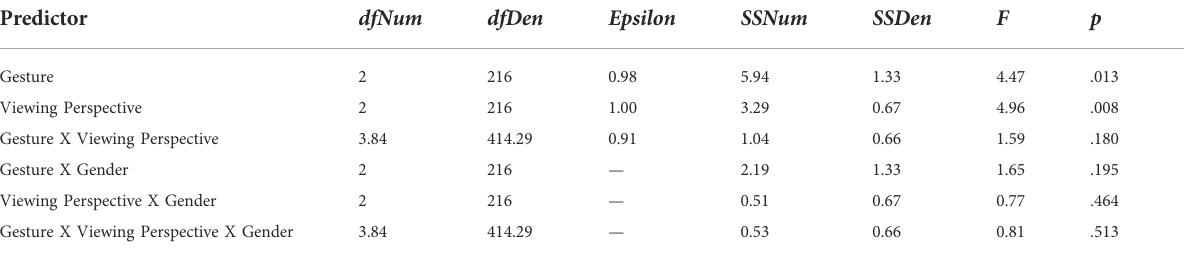
TABLE 5 Results of the mixed-measures ANOVA for the perceived dominance of the robot. Predictor